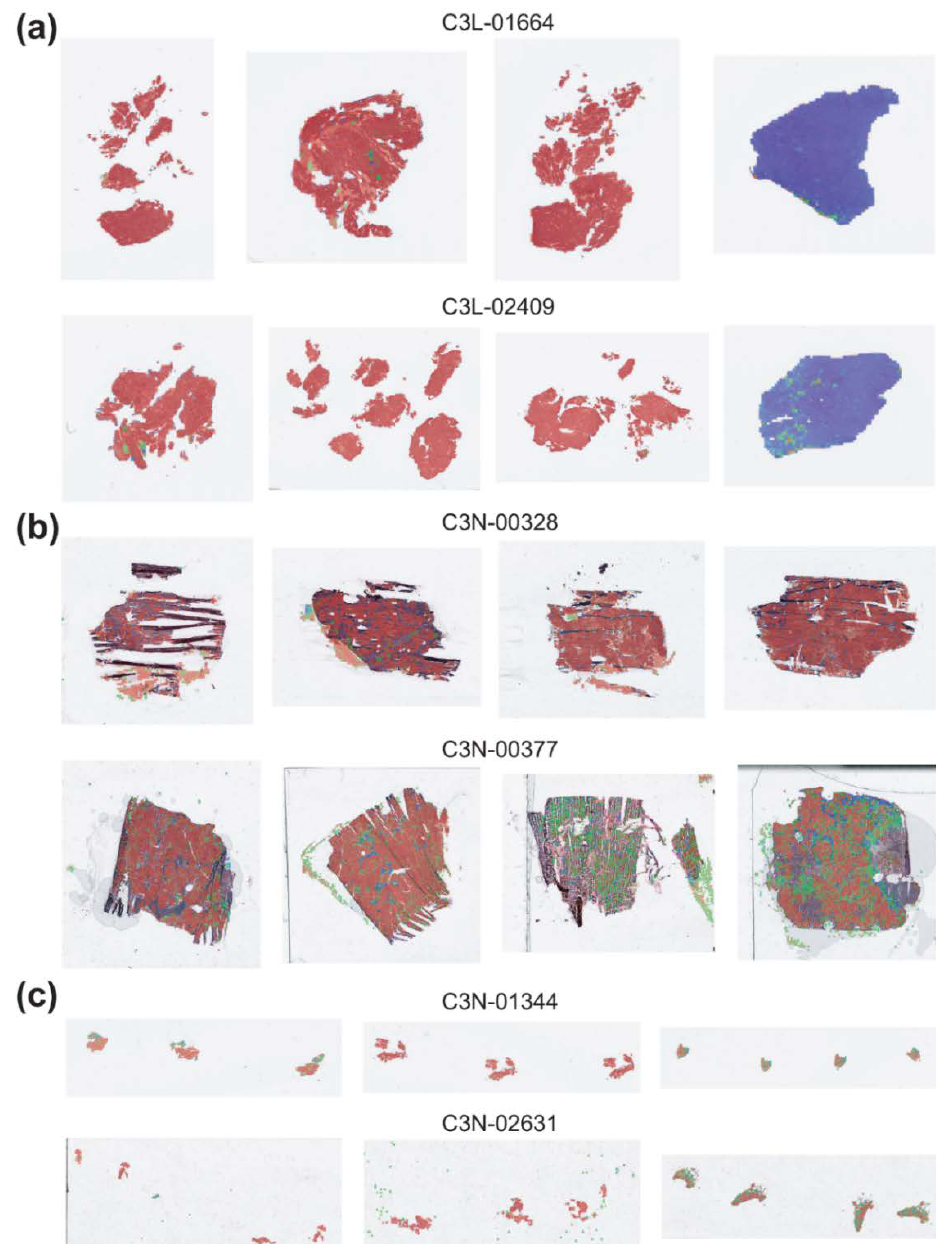
Figure 5. Characteristics of CPTAC-UCEC tissues. Examples of tissues from six patients indicated by IDs. ( a ) Patients with both pure tumor and pure normal tissue samples. ( b ) Patients with frozen tissue samples. ( c ) Patients with small curettage tissue samples.